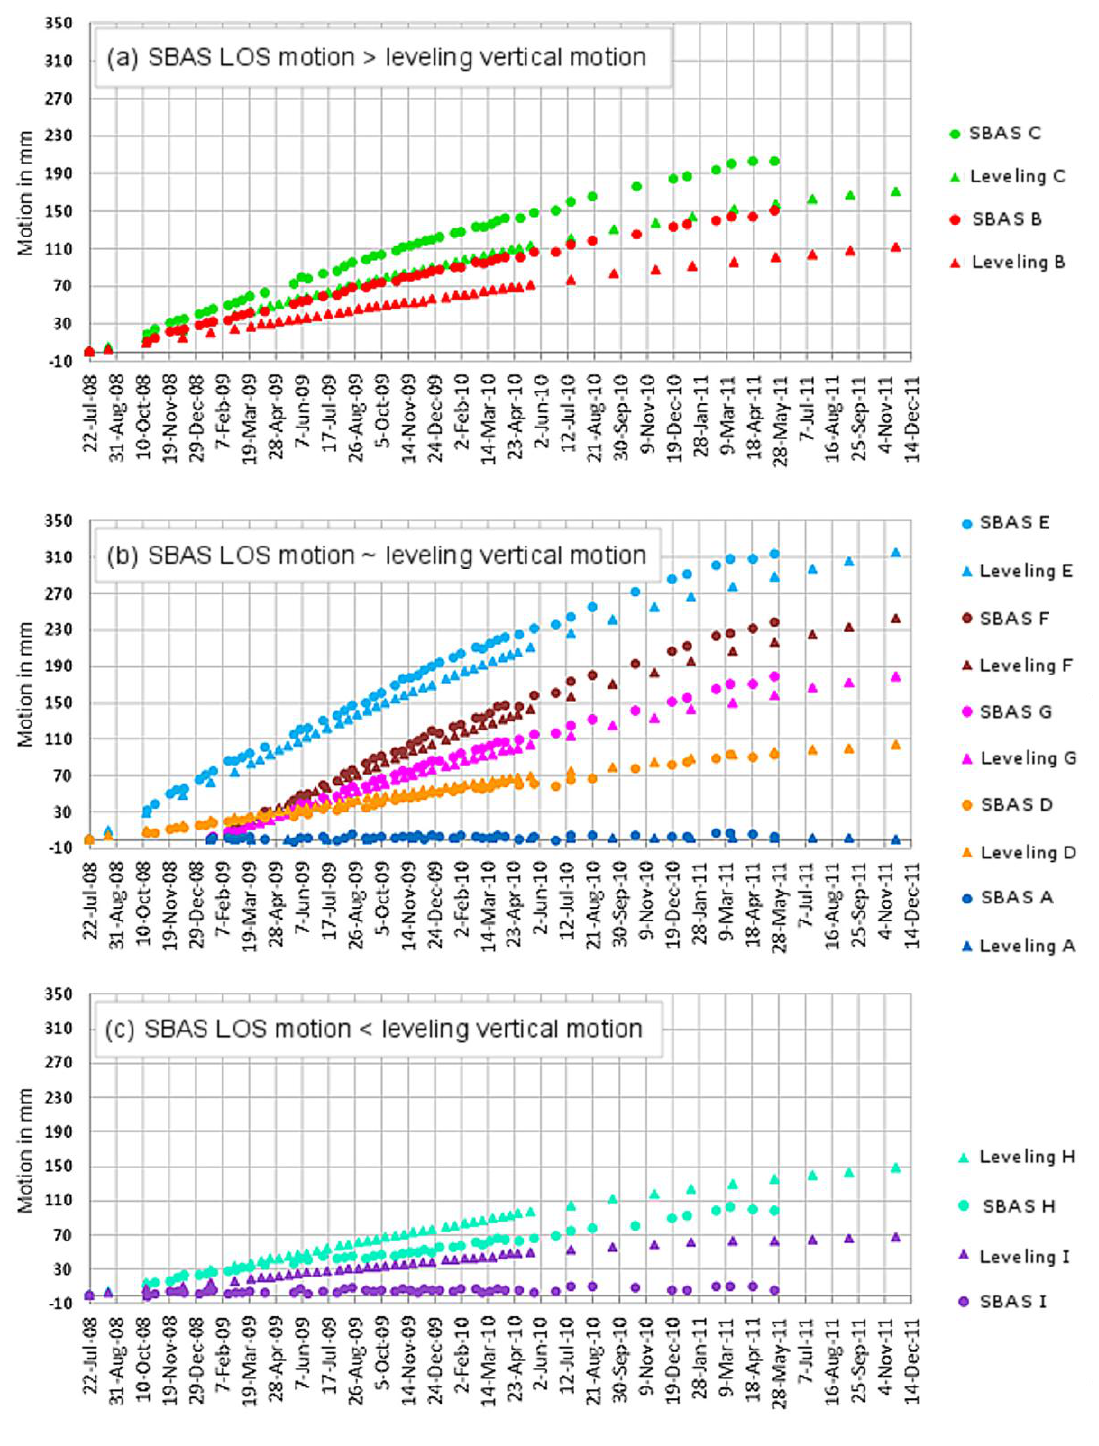
Figure 10. Time series of the vertical motion of selected leveling points (Figure 9) and the LOS displacement of SBAS SDFP pixels, which are located in their immediate vicinity. Corresponding points are in the same color. The separation into the three subfigures is due to the classification of three specific groups as indicated in the upper left corner of each diagram and described in the text (see Section